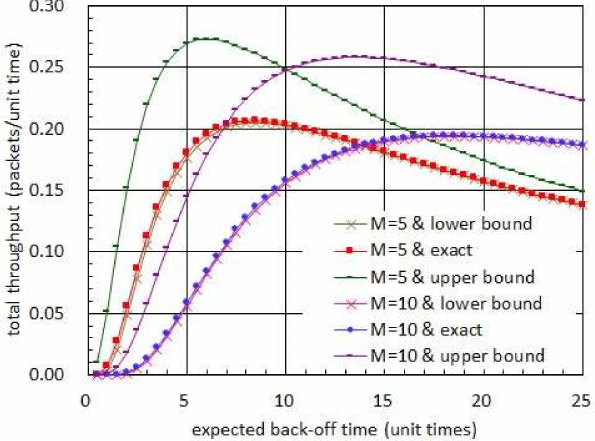
Figure 8. Total throughput with respect to expected back-o ff time when harvest time is shorter than transmission